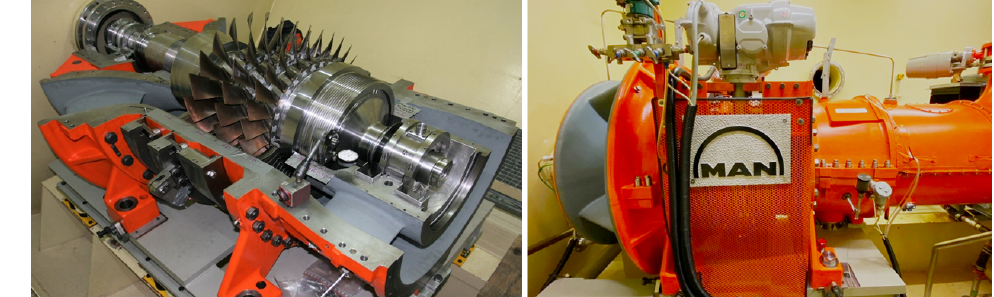
Figure 2. New 3-stage axial compressor ( left : during installation, right : final